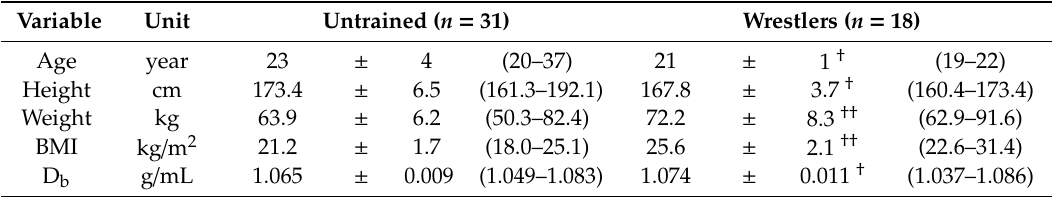
Table 1. Anthropometric characteristics.